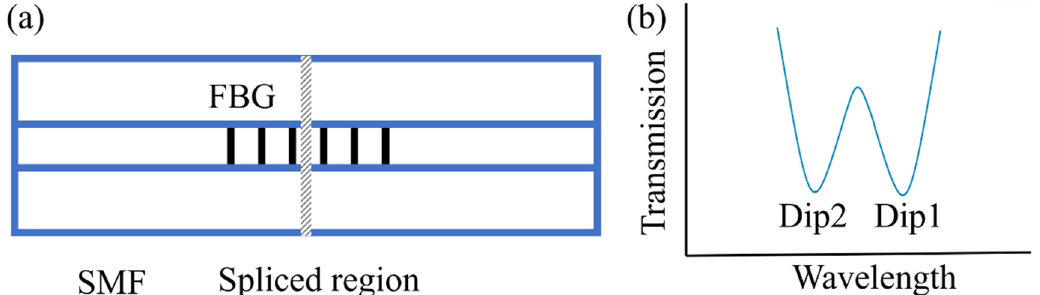
Figure 4. ( a ) Schematic diagram of the PS-FBG, modulated by a fusion spliced region. ( b ) The spectrum diagram of the PS-FBG fabricated by fusion splicing technology.